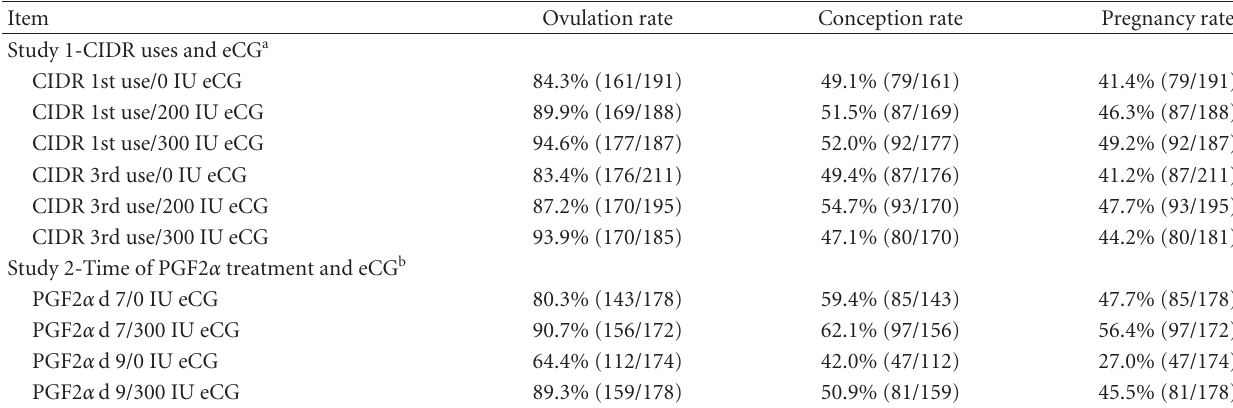
Table 5: Ovulation, conception, and pregnancy rates of Bos indicus pubertal heifers (Study 1) and nonlactating cows (Study 2) submitted to a synchronization of ovulation protocol using progesterone associated with estradiol having di ff erent strategies to improve fertility. Adapted from Peres et al.